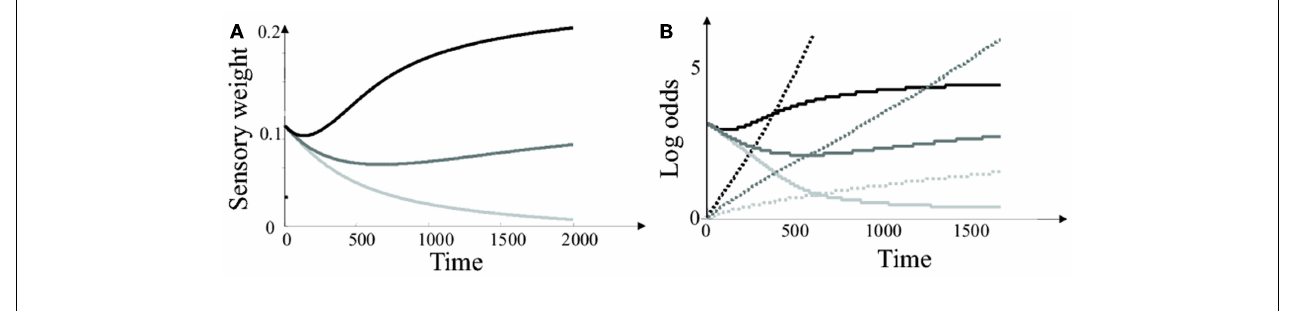
FIGURE 3 | Simplified Bayesian model. (A) Sensory weights in the simplified Bayesian model (average of 20000 trials) as a function of time after stimulus presentation. Black line: c = 2. Light gray line: c = 0 (i.e., sensory input is pure noise). Dark gray line: c = 1. (B) Average log odds L t (plain lines) and decision threshold (dashed lines) in the simplified